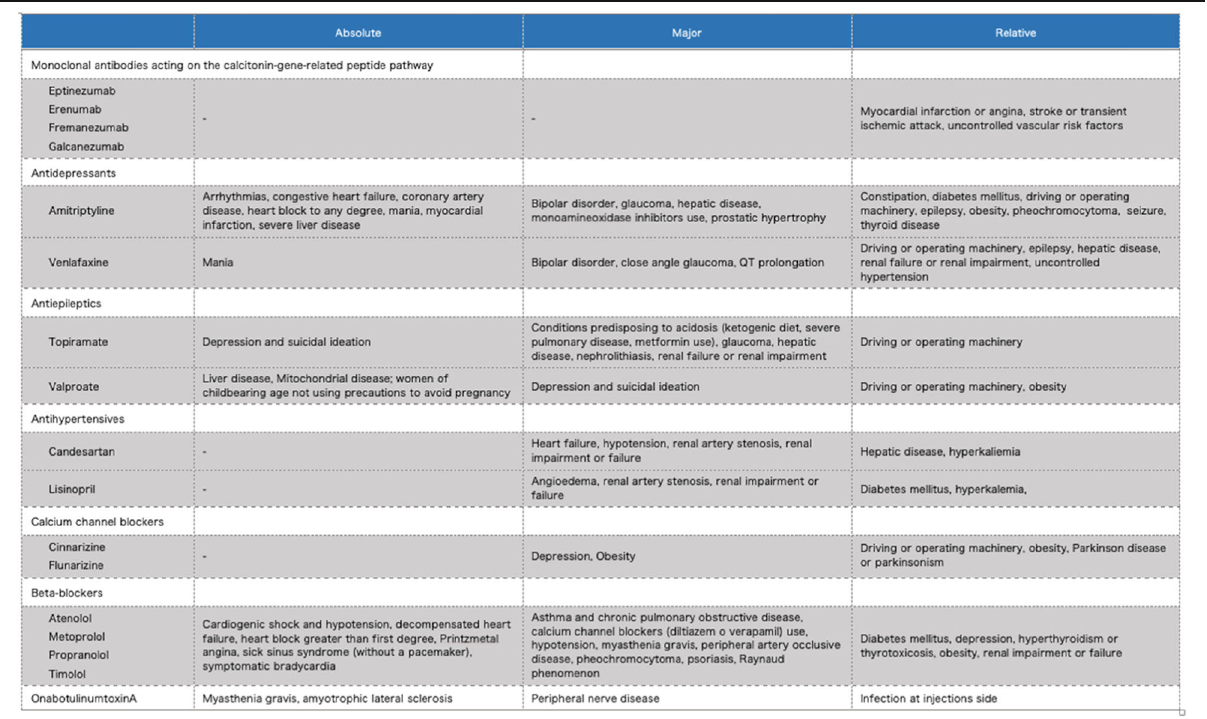
Table 5 Absolute, major and relative contraindications to drugs for migraine